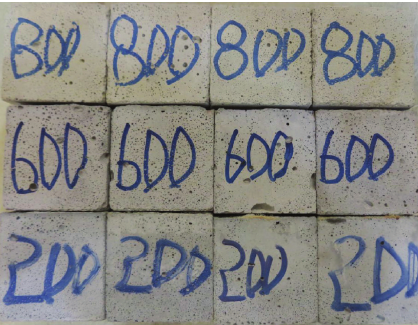
Figure 3: Color changes and surface cracks of postfire specimens.